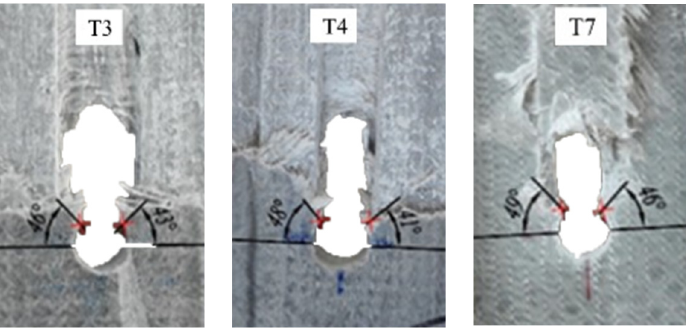
Figure 5. Shear failure at 45° of the bolt hole